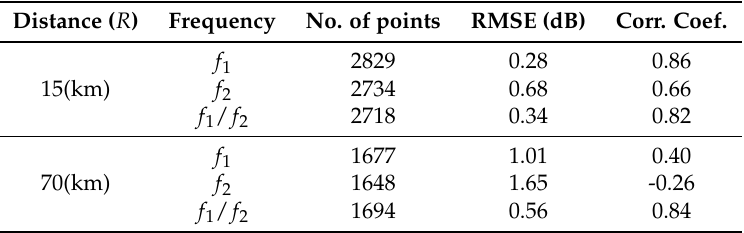
Table 4. Statistics of wave height estimation between radar and